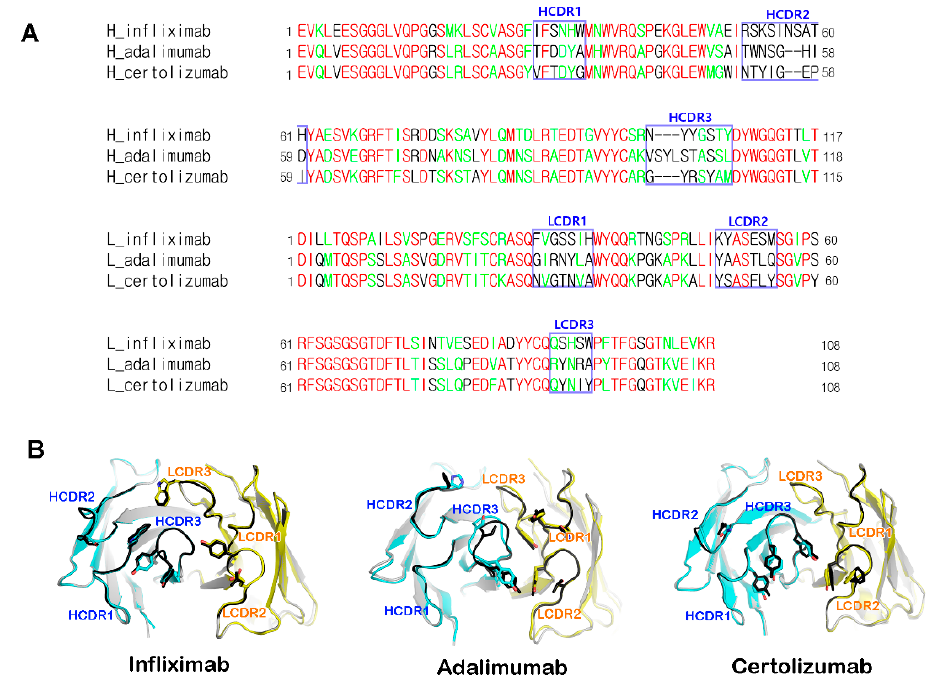
Figure 4. Complementarity-determining regions (CDR) loops within anti-TNF α antibodies. ( A ) Sequence comparison of the anti-TNF α antibodies. CDRs are indicated with boxes and labeled. Identical and homologous residues are colored red and green, respectively; ( B ) Superposition of the free Fab fragments of anti-TNF α antibodies (gray; CDR regions: black) onto the Fab fragment extracted from the complexes with TNF α (heavy chain: cyan; light chain: yellow).